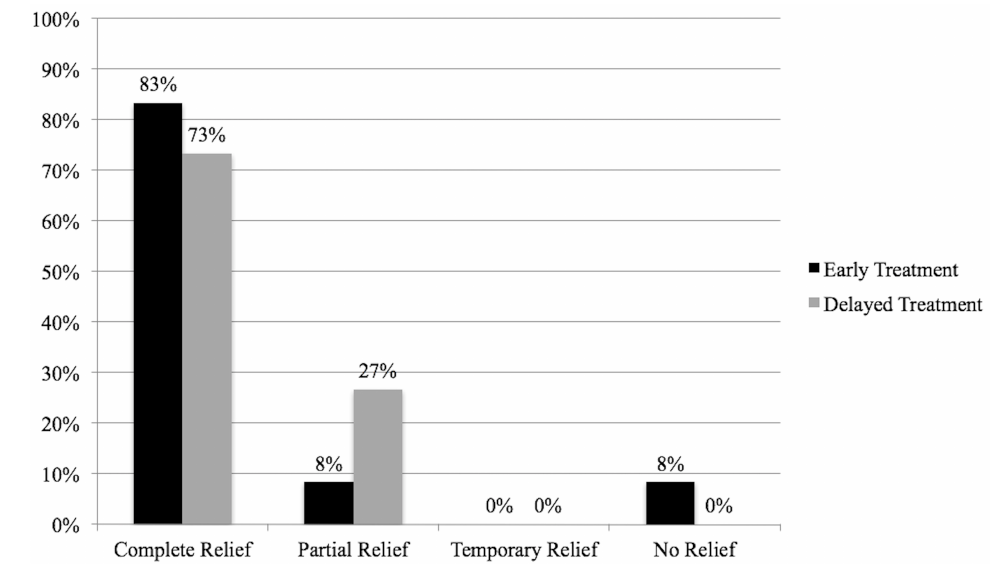
Figure 3. Outcomes after FRR less than or greater than six weeks after presentation.